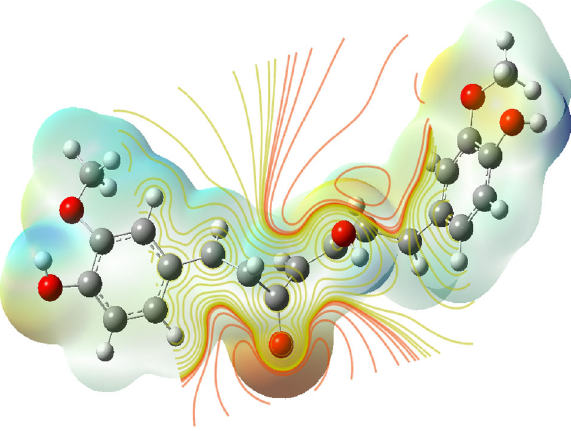
Fig. 15 Electron density maps of curcumin